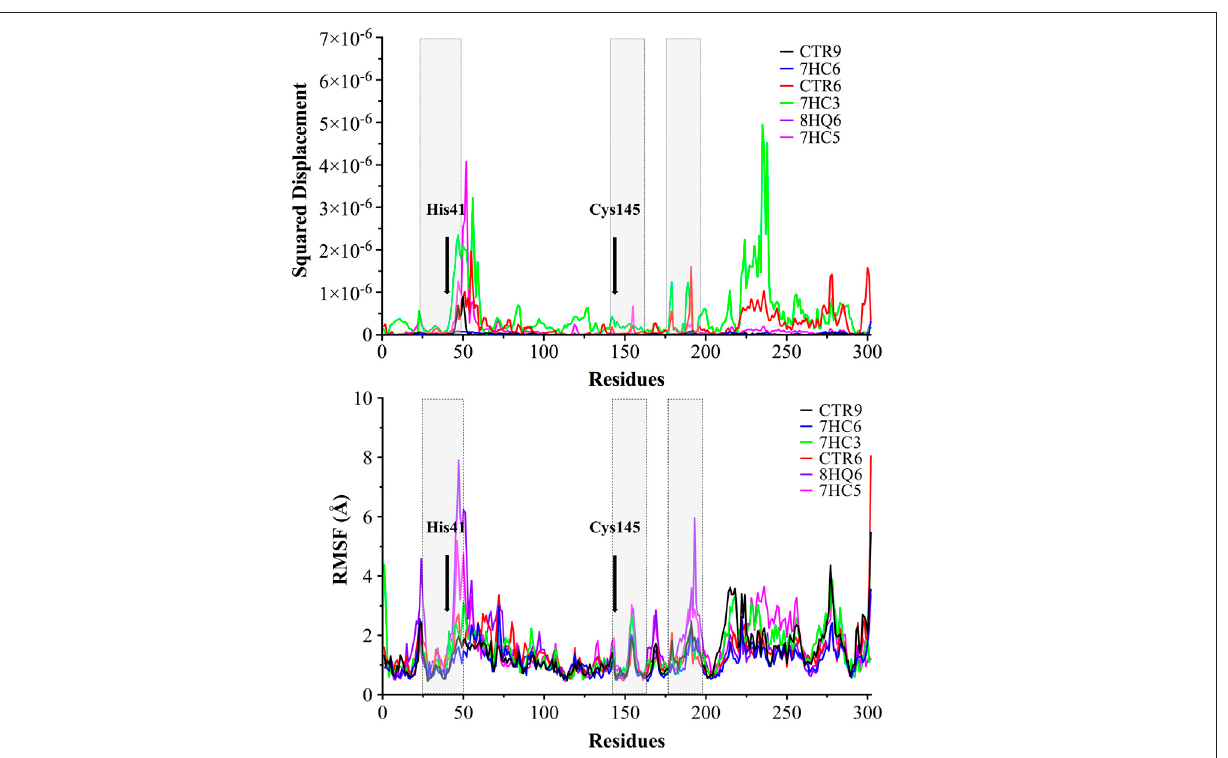
FIGURE 5 | Normal Mode Analysis and RMSF of the α -carbon. A main component analysis was carried out using the last 100 ns trajectories, and the main normal modeofmovementwasobtained.ThedisplacementwasplottedforeachresidueofSARS-CoV-2M pro incomplexwithCTR9,7HC6,CTR6,7HC3,8HQ6and7HC5.In grey boxes represented pocket site residues. His41 and Cys145 residues of the catalytic site are highlighted with bold